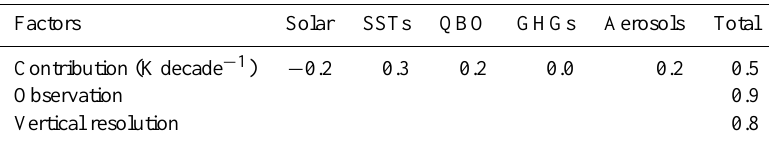
Table 3. Summary of contributions from the varying factors to the observed TTL warming between 2001 and 2011, in the region 20 ◦ S–20 ◦ N latitude and